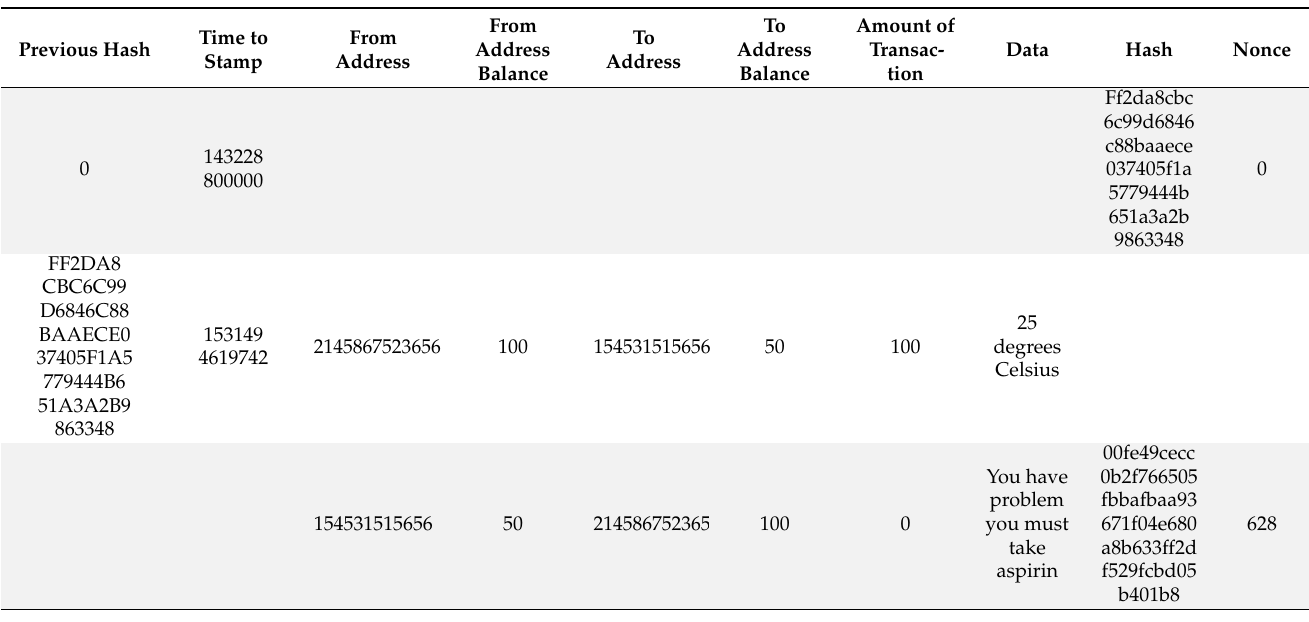
Table 8. Blockchain